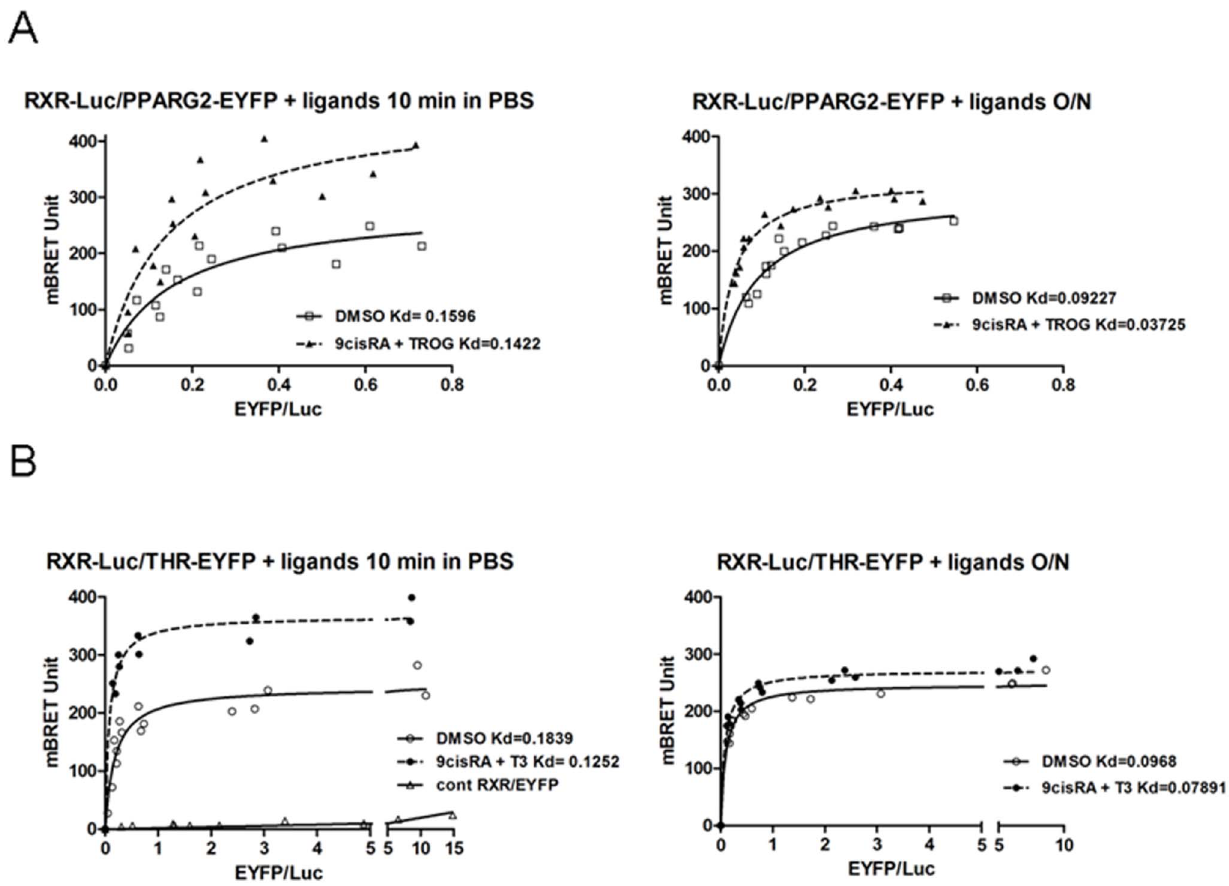
Figure 3. Titration BRET experiments in living cells. BRET between RXR-Luc and PPARG2-EYFP, RXR-Luc and THR-EYFP. Regression curves are represented with the BRET value as a function of the fluorescence/luminescence ratio (EYFP/Luc). HEK293T cells were transfected with a fixed amount of RXR-Luc donor plasmid together with increasing amount of acceptor plasmids (PPARG2-EYFP above or THR-EYFP and EYFP lower) and BRET was measured in living cells after stimulation with control DMSO or ligands either on resuspended cells 5–10 minutes in PBS (left panel), or on adherent cells during an overnight (O/N) incubation in culture medium (right panel). Values represent BRET measures (each in triplicate) integrated over a 20 min reading (A), BRET titration curves between RXR-Luc and PPARG2-EYFP from control cells (open square) and from cells stimulated 5 min with ligands 9cis RA + TROG (filled triangle) in PBS resuspended cells (left panel) or from adherent cells stimulated O/N (right panel) (B), BRET titration curves between RXR-Luc and THR-EYFP from control cells (open circles) and from cells stimulated 5 min with 9cisRA + T3 (filled circles) in PBS (left panel) or from adherent cells stimulated O/N (right panel) (right panel). A negative control saturation experiment is also shown between a RXR-Luc donor and an unfused EYFP acceptor protein (open triangle). Apparent affinity (apparent Kd) between RXR-Luc and PPARG2-EYFP or RXR-Luc and THR-EYFP represents EYFP/Luc ratio corresponding to the BRETmax/2 value (BRET50). Shown are cumulative data from three independent experiments in